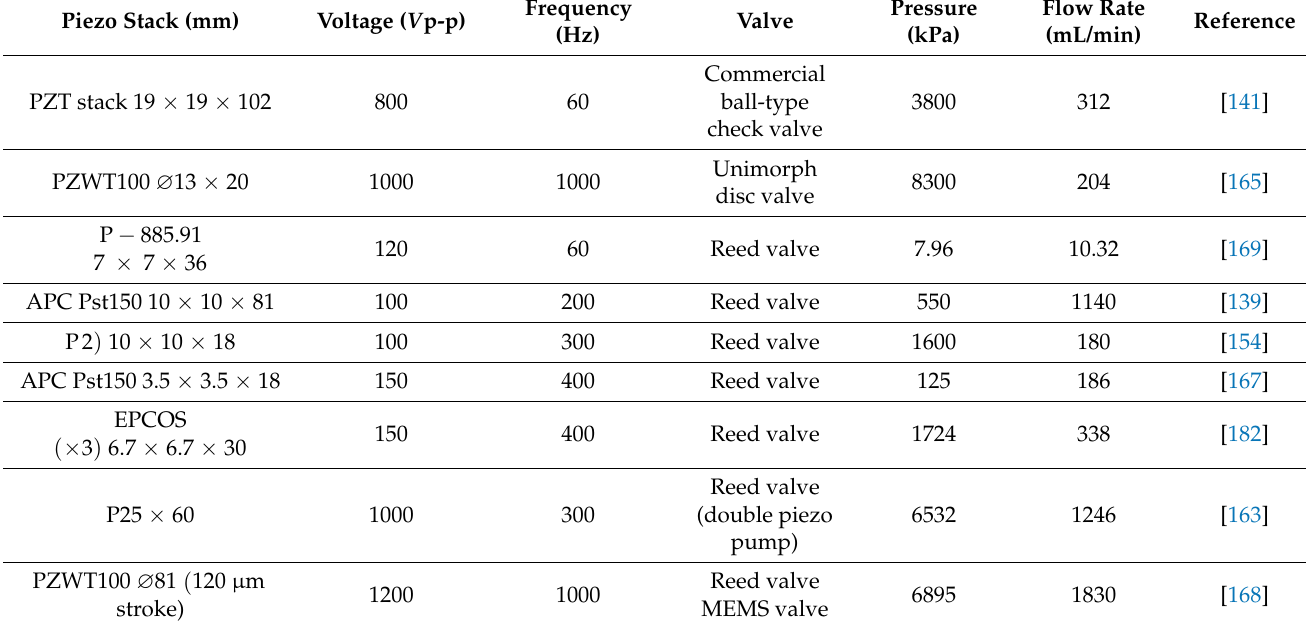
Table 8. Summary of the performance of several piezoelectric–hydraulic